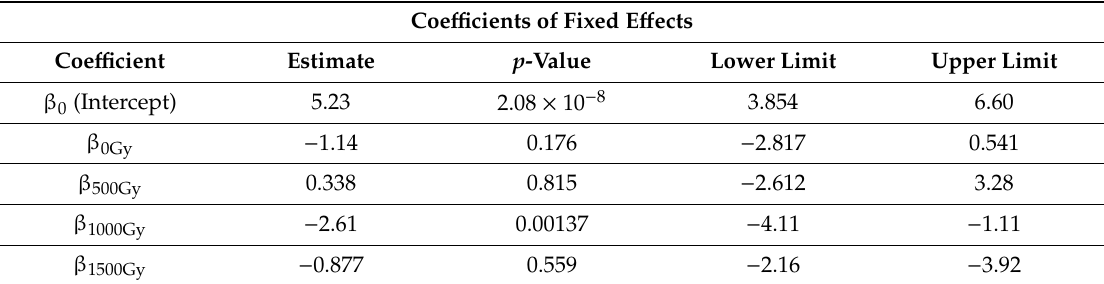
Table 3. Parameters calculated by LMM analysis to evaluate changes in activities of the body-wall muscle cells around the tail between before and after targeted